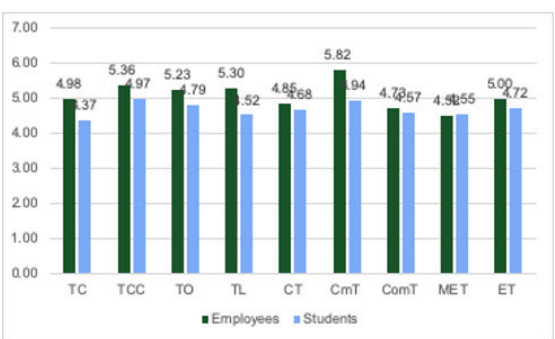
contrary to the previous figure.